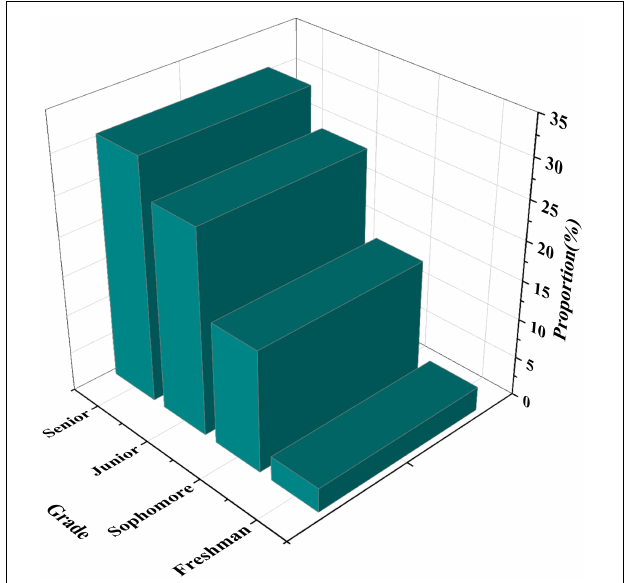
FIGURE 6 | Statistics of the entrepreneurial intention of students in different grades.